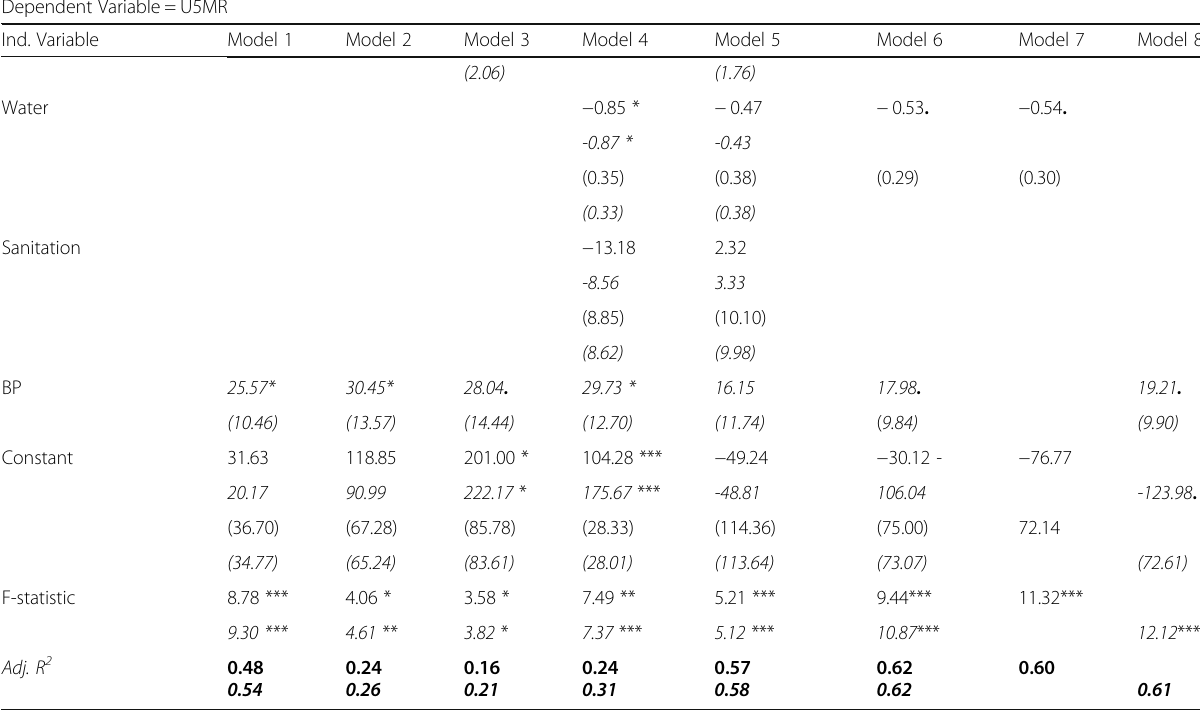
Table 5 Results for multivariate regression models with U5MR in 2010 as DV (Continued) Dependent Variable = U5MR Ind. Variable